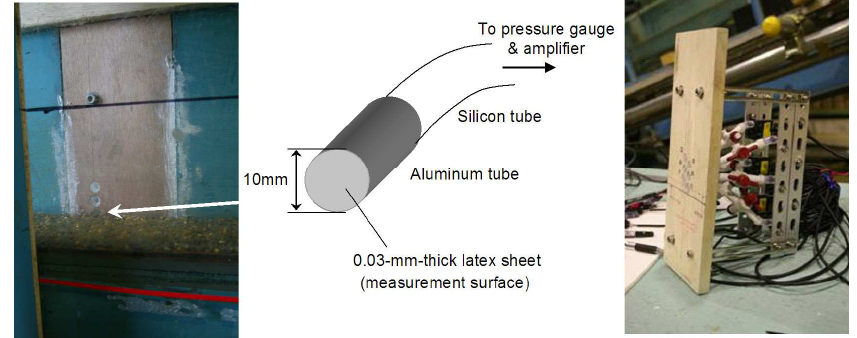
Fig. 2. Measurement system. Although several measurement surfaces are shown in the figure, only the measurement surface at the bed height was used.